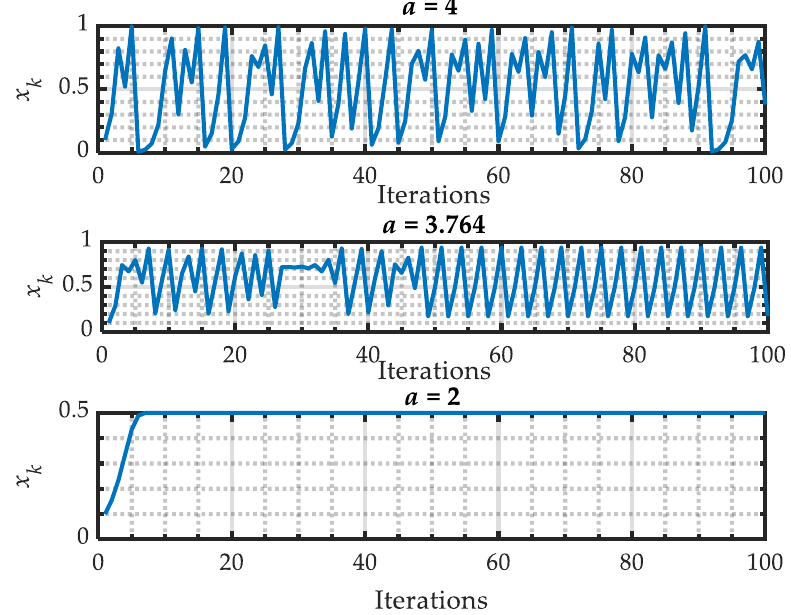
Figure 4. 1-D plots for the Sine map.